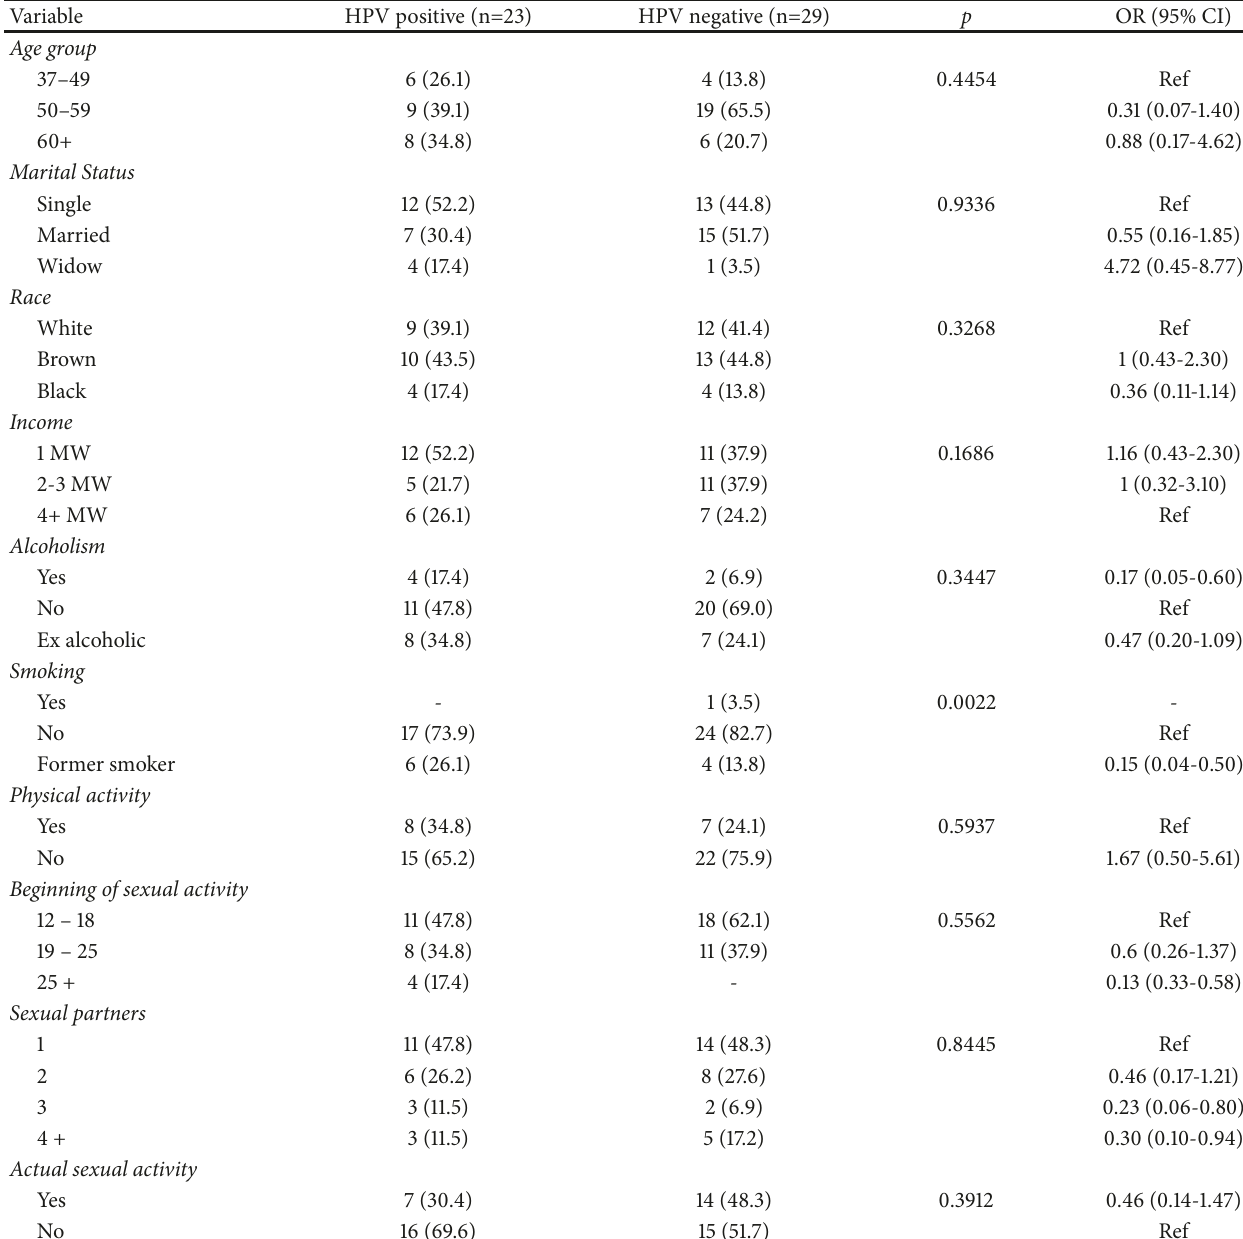
Table 1: Association between sociodemographic characteristics of participants and HPV